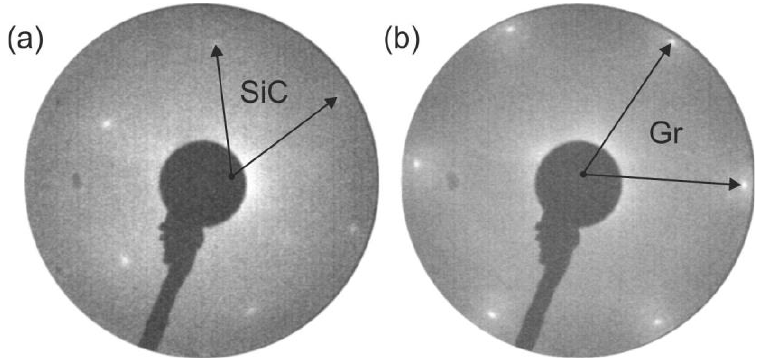
Figure 1. LEED patterns of ( a ) 6H-SiC(0001) (1 × 1) surface; ( b ) (1 × 1) graphite (Gr) obtained after annealing the surface from ( a ). Images taken for 79 eV. The arrows show the reciprocal unit vectors. The MgO/SiC and MgO/graphite/SiC systems were characterized by an X-ray pho- toelectron spectroscopy (XPS) using a radiation source with an Mg K α line (1253.6